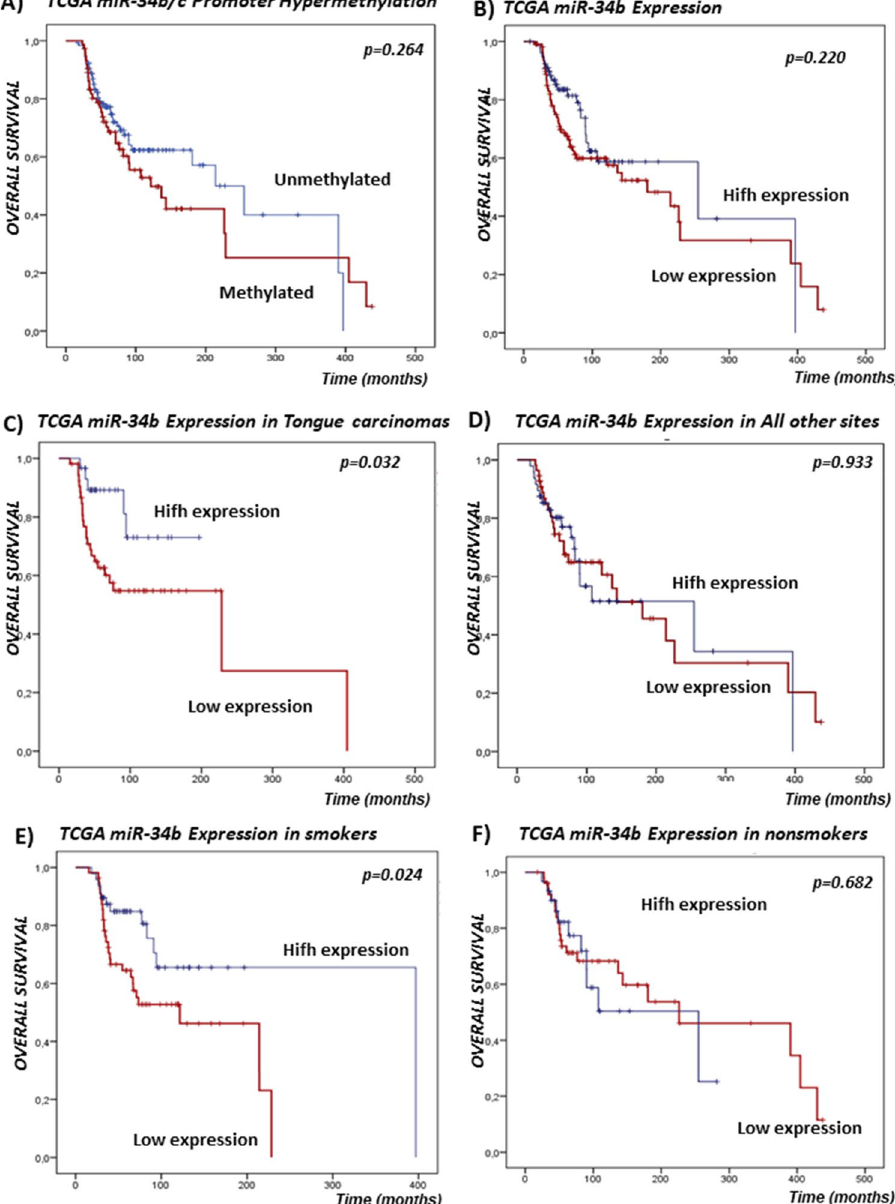
Figure 3. Kaplan–Meier curves with log-rank test for overall survival (OS) of the TCGA cohort. ( A ) Survival according to the miR-34b/c promoter hypermethylation status. ( B ) Survival according to the miR-34b gene expression. ( C ) Survival according to the miR-34b expression in tongue carcinomas patients. ( D ) Survival according to the miR-34b expression in patients with OSCC of all other sites. ( E ) Survival according to the miR- 34b expression in smokers. ( F ) Survival according to the miR-34b expression in